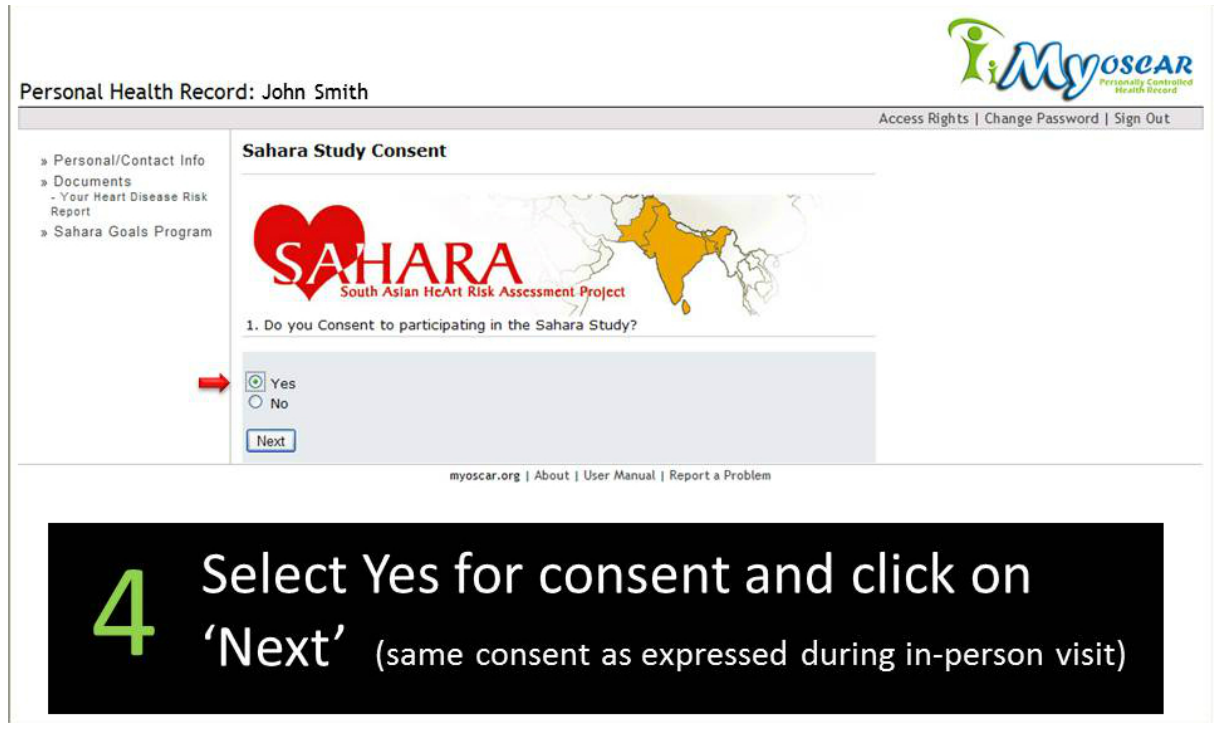
Figure 7. SAHARA Web consent and personal health record